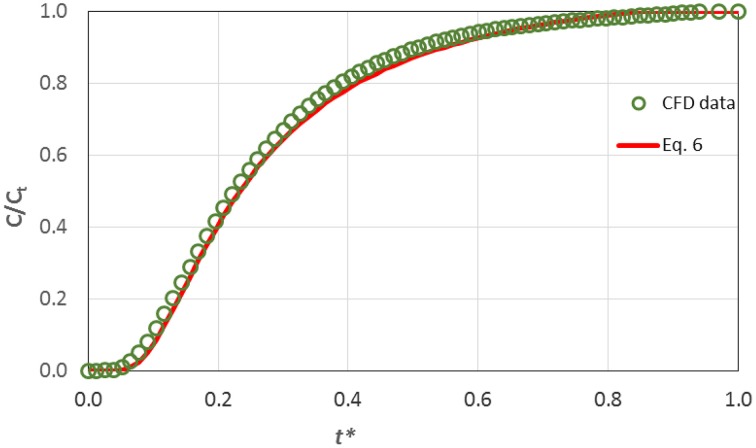
Comparison of CFD results on the transdentinal diffusion of a protein (Rs = 2.2 nm, C0 = 0.10 mg/mL) with the prediction of Equation (6).